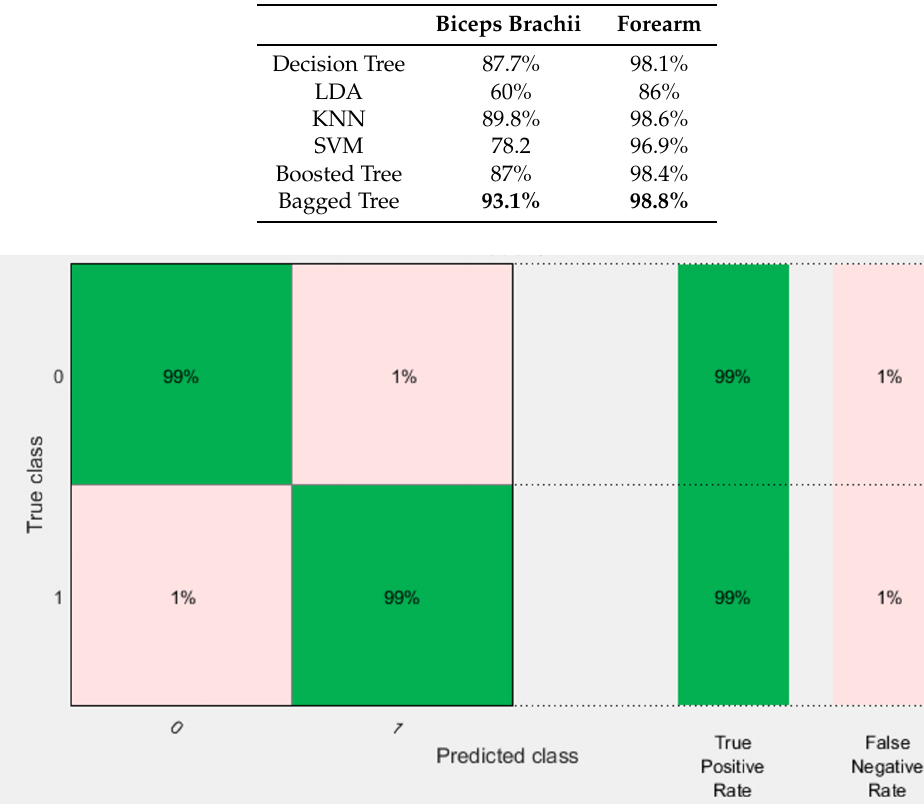
Table 3. Classification accuracies for EMG sensor.